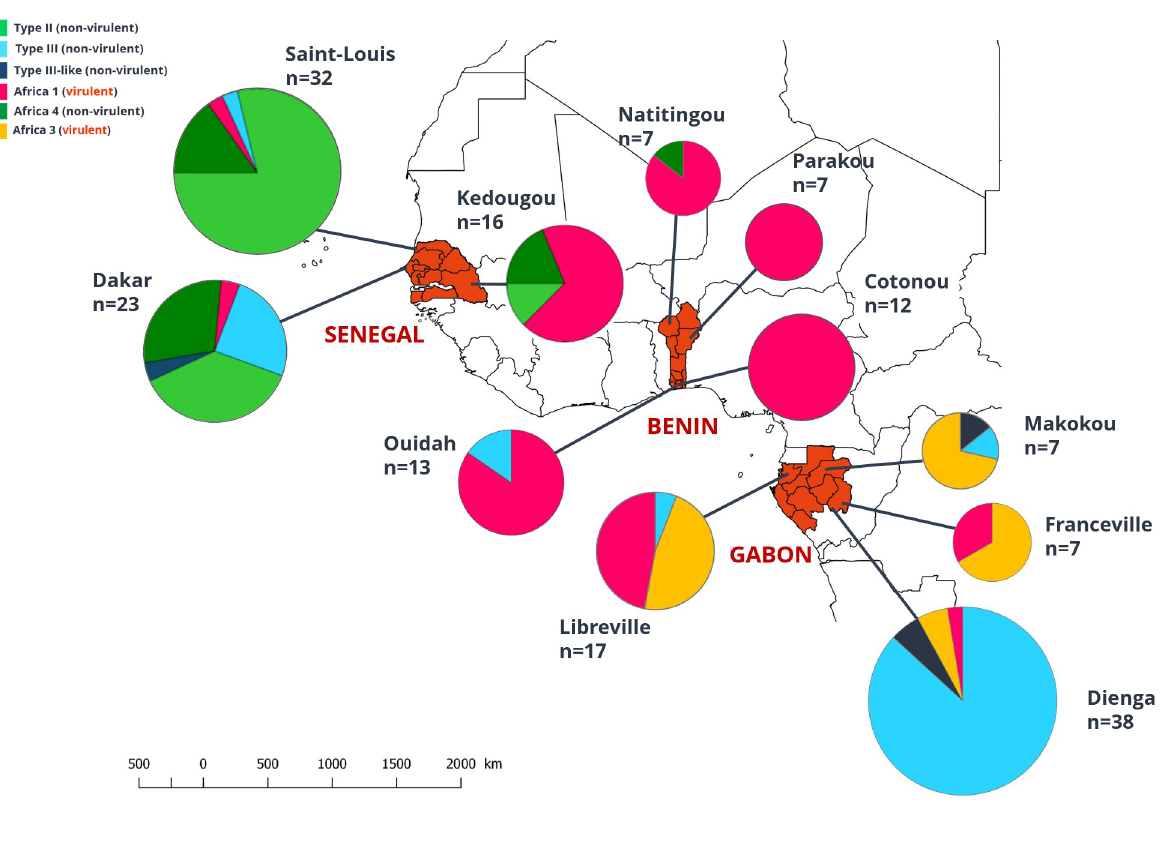
Fig 1. Geographical distribution of Senegalese (modified from Galal et al., 2019), Beninese and Gabonese Toxoplasma gondii strains. Map of the distribution of Toxoplasma gondii of isolates fully genotyped by 15-MS genotyping. Size of pie charts correlate with the total number of isolates and colors indicate the different clonal lineages